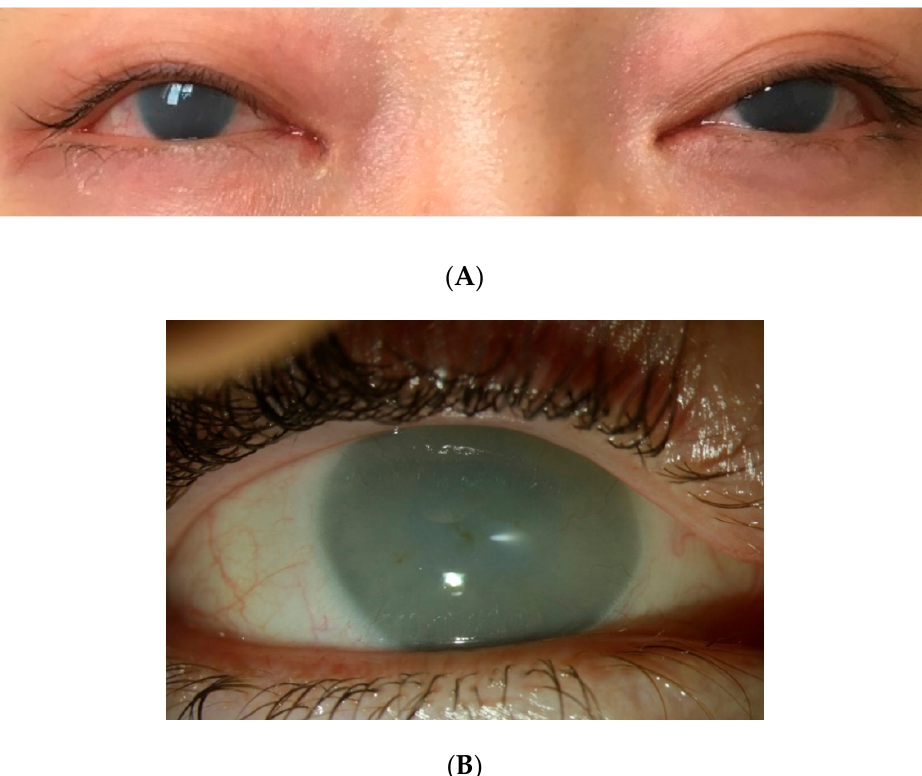
Figure 2. Corneal clouding in MPS I. The top picture ( A ) shows a 19-year-old patient. The bottom picture ( B ) shows a 38-year-old patient. No systemic treatment for both patients.